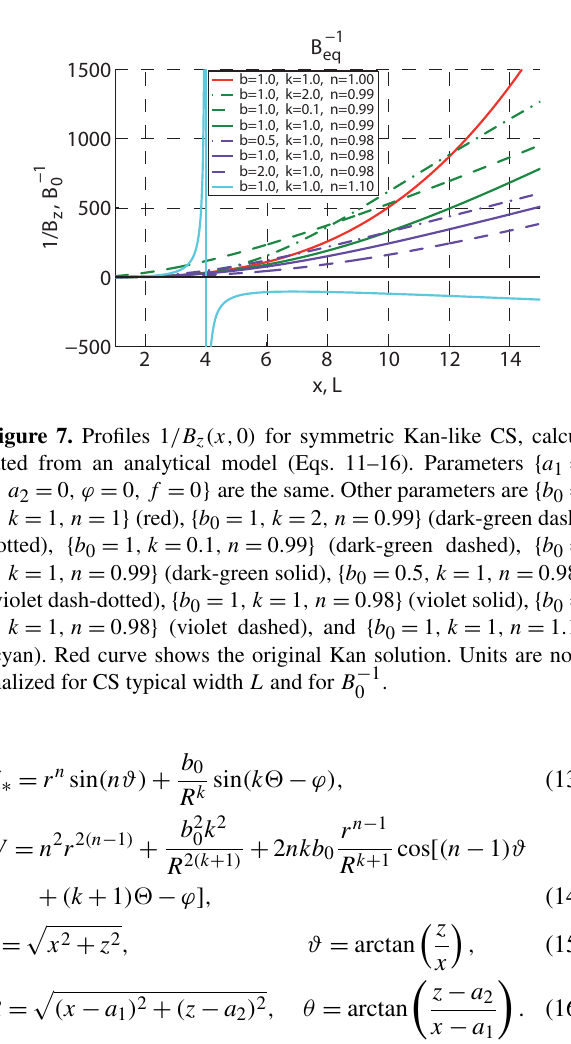
For symmetric Kan-like CS without plasmoids ( a = 0 , f = 0 , ϕ = 0), the quantity B z at the x axis takes the simple form B z (x, 0 ) = − (∂W/∂x)/( 2 W) . It is seen that the Kan solution ( n = 1) is the only degenerated case when the first term of W turns to 1 and its derivative to zero; hence, in the distant tail B z ∼ ( 1 /x 2 + k ) due to the rightmost term of expression (14). For any n (cid:54)= 1 we have (∂W/∂x)/W → O( 1 /x) . Parameter n controls flaring of magnetic field lines; values of n > 1 force strong convergence of the CS field lines to- ward the x axis, and hence the location of the X-line is dras- tically dependent on n . This feature is illustrated in Fig. 6, where four symmetric magnetic configurations with (a = 0 , ϕ = 0 , f = 0 , b 0 = 1 , k = 1 ) and n = { 0 . 95 , 1 , 1 . 05 , 1 . 1 } are plotted. In Fig. 7 reverse values of the equatorial magnetic (x, 0 ) , are plotted for several sets of the model pa- field, B − 1 z rameters. The set of green curves illustrates contribution of the parameter k . The set of violet curves shows the effect of the parameter b 0 variation. The set of solid curves demon- strates the parameters n impact. It is seen that (a) all curves except the red one (original Kan solution, n = 1) tend